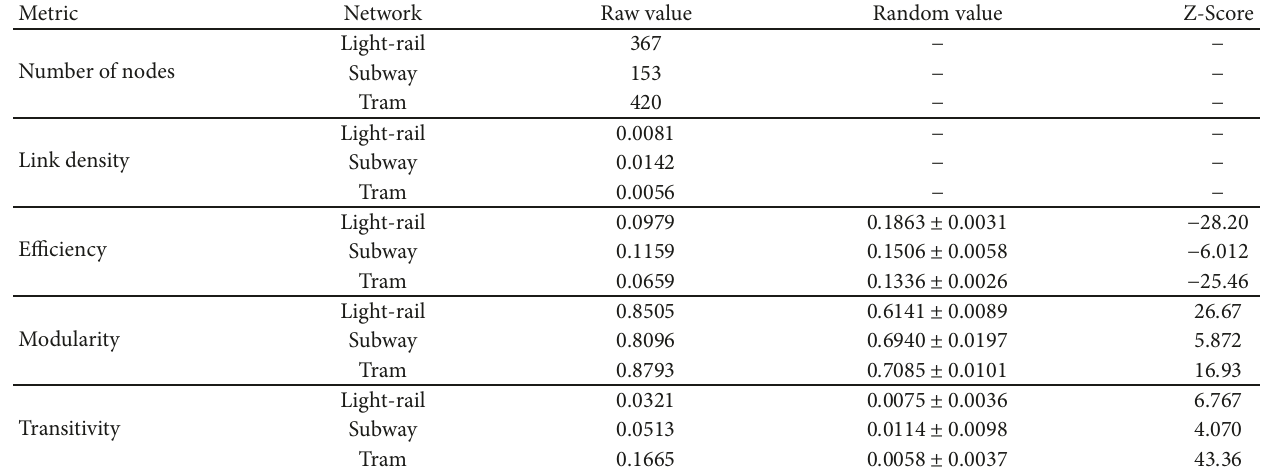
Table 2: Examples of topological metrics calculated over three networks described in Appendix. The three rightmost columns, respectively, report the raw metric value (i.e., as calculated on the original network), the average and standard deviation of the metric obtained in random equivalent networks, and the final